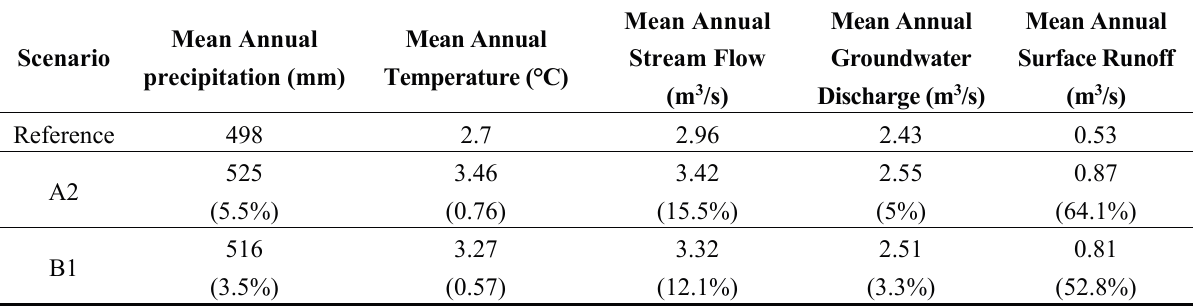
Table 5. Mean annual precipitation, temperature, stream flow, surface runoff, and groundwater discharge over the reference period (2000–2011) and A2 and B1 scenarios for the long-term period (2020–2040). The values within the parentheses are relative changes except for temperature, where absolute changes were